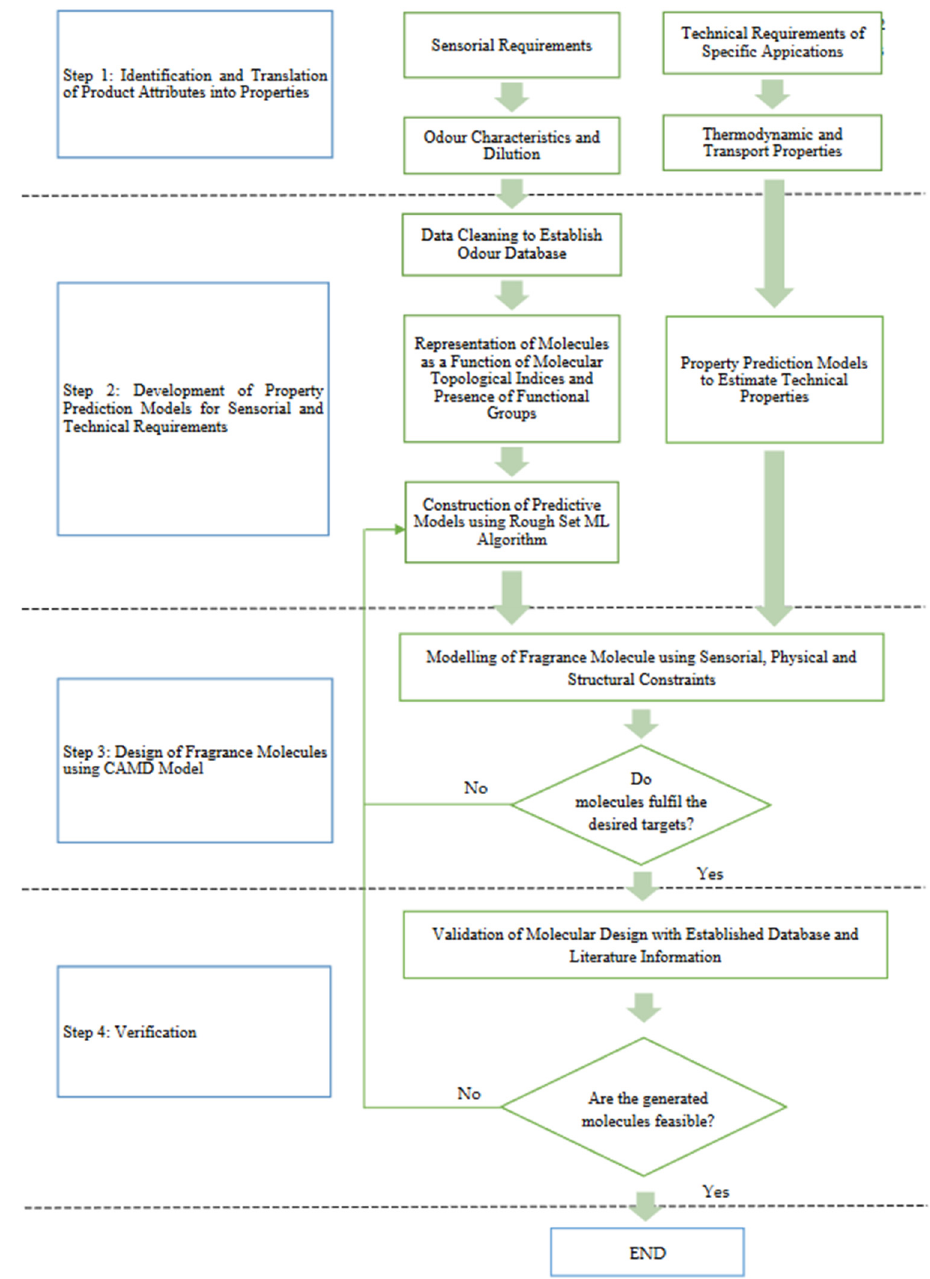
Figure 1. Integrated ML and CAMD